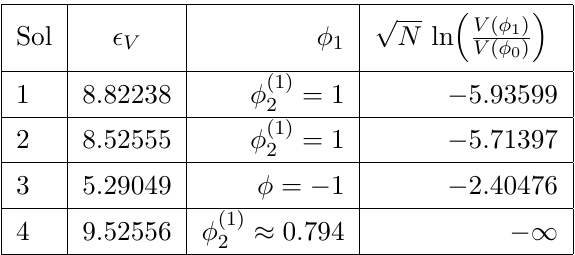
Table 1 . Values of (cid:15) V and Here (cid:30) 1 is the steepest